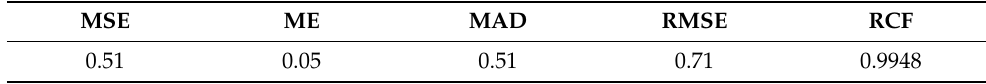
Table 7. Evaluation metrics of SpO 2 for the reflection-type fingertip